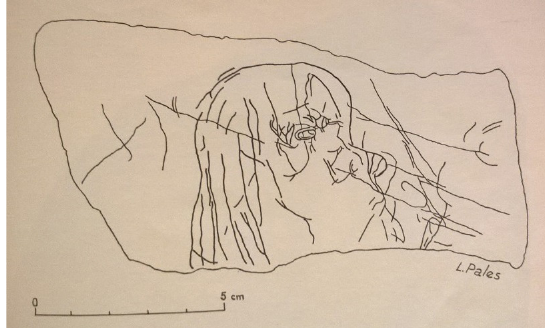
Figure 9. Group α, examples of Hand α2: Obs. 19(II) (from Pales, 1976).